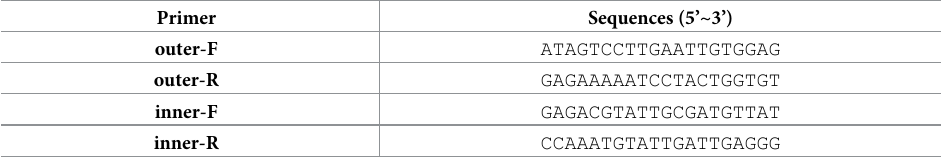
Table 2. Primer sequences for PeTPS-(-)Apin gene cloning.